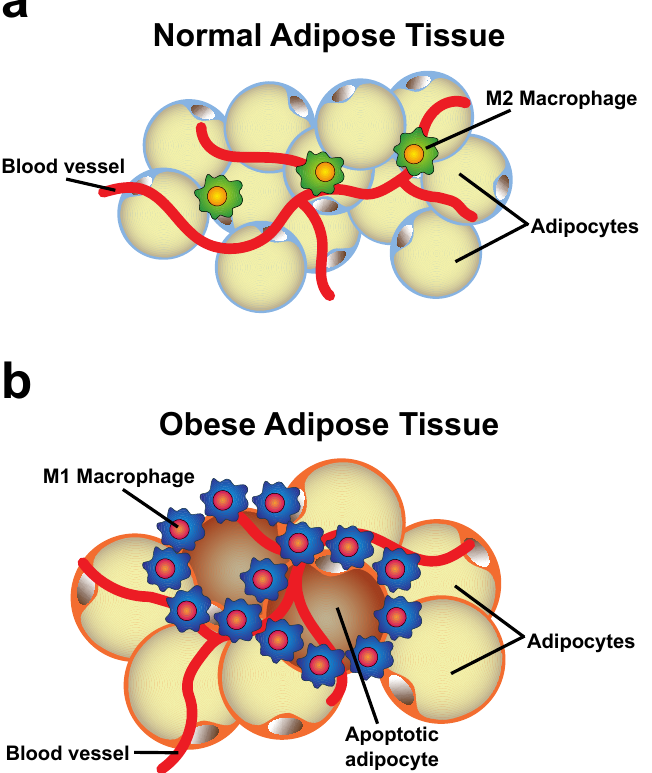
Figure 1. Changes in the adipose tissue. ( a ) In normal adipose tissue, adipocytes store limited amounts of fat (triglycerides). Some anti-inflammatory M2 macrophages are distributed throughout the tissue. ( b ) In obese adipose tissue, adipocytes accumulate excessive amounts of fat and become larger and stressed. These adipocytes then become dysfunctional, releasing proinflammatory adipokines that recruit and activate more macrophages into the tissue. Macrophage activation results in an increase in macrophages with the M1 (proinflammatory) phenotype and a decrease in M2 (anti-inflammatory) macrophages. Due to hypoxia and stress, adipocytes also become apoptotic. Macrophages concentrate around apoptotic and dead adipocytes, forming crown-like structures where defective adipocytes are eliminated by phagocytosis.